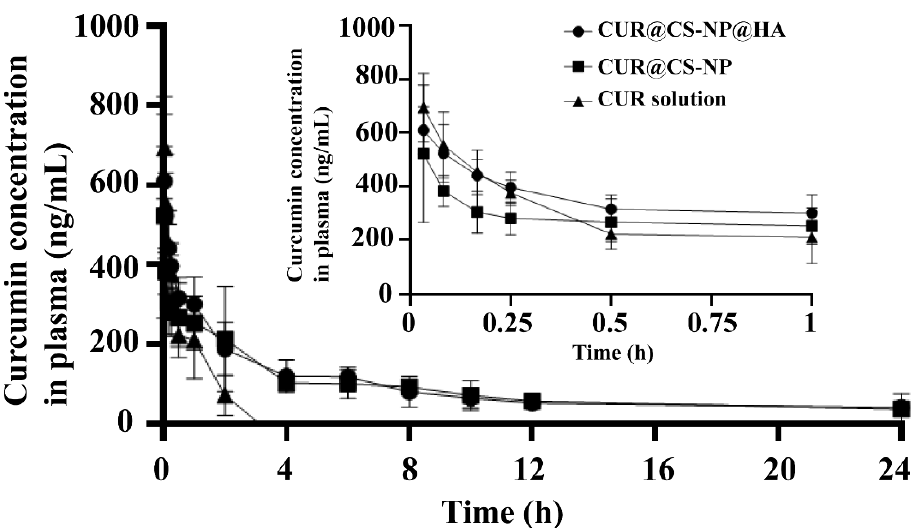
Figure 6. Time–mean drug plasma concentration profiles of CUR@CS-NP and CUR@CS-NP@HA fabricated by CS HMW - g -PN polymer in rats (1.5 mg/kg). Free CUR was used as the control.